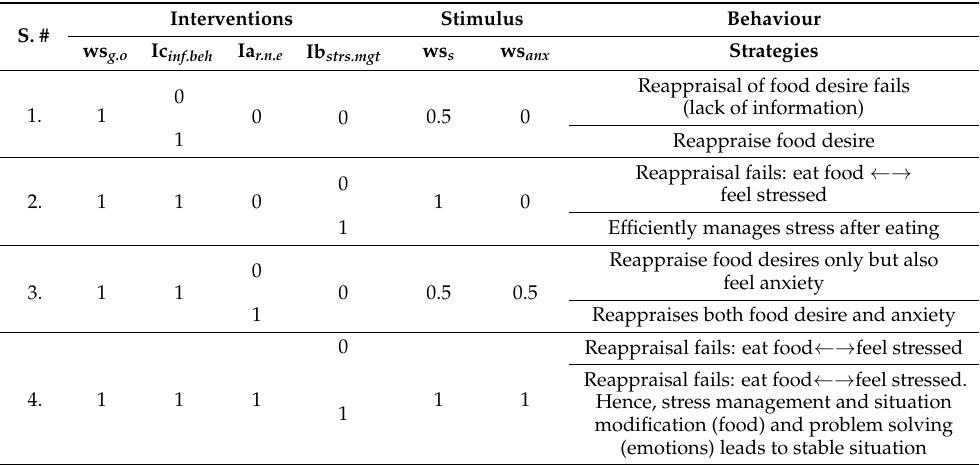
Table 4. Initial values of the key states and expected simulation results. S.